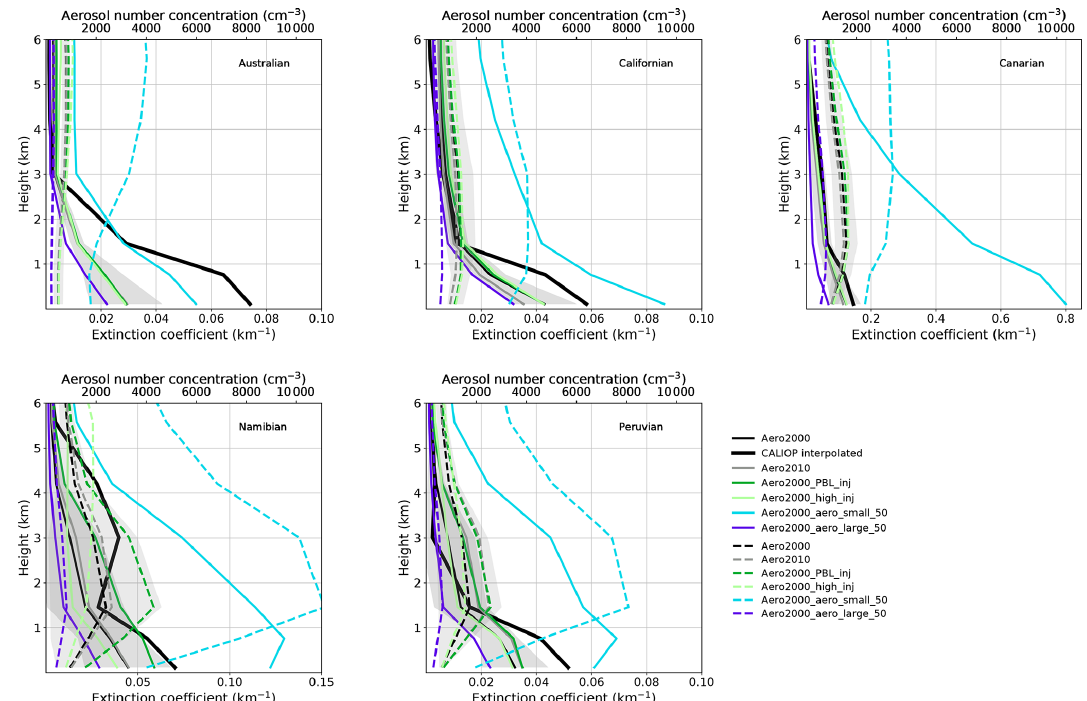
Figure 3. Vertical distribution of the aerosol extinction coefficient (km − 1 ; solid line) and aerosol number concentration (cm − 3 ; dashed line) for the Australian, Californian, Canarian, Namibian, and Peruvian regions for the model control simulation and sensitivity experiments in the category emissions. The SD of the model control simulation is indicated as a grey shaded area.